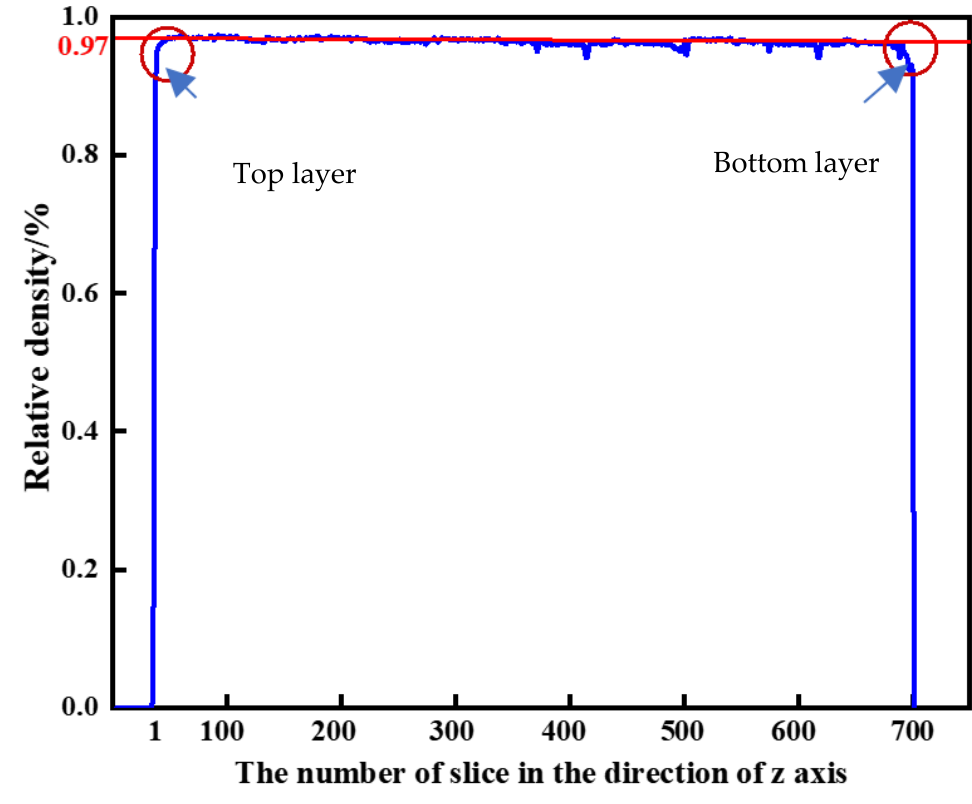
Figure 11. Image from inside to outside layer of plane obtained via XCT analysis in sample 2. ( a ) Top plane in XOY; ( b ) middle plane in XOY; ( c ) bottom plane in XOY; ( d ) back plane in YOZ; ( e ) middle plane in YOZ; ( f ) front plane in YOZ; ( g ) left side plane in XOZ; ( h ) middle plane in XOZ; ( i ) right outermost side plane in XOZ.